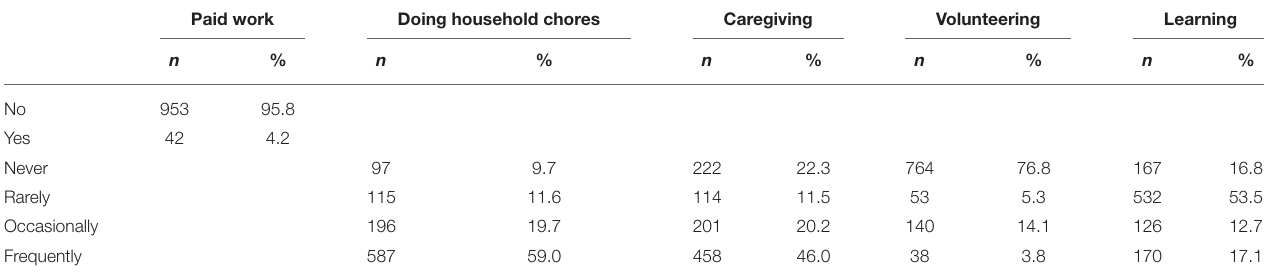
TABLE 3 | Productive aging status of the participants.